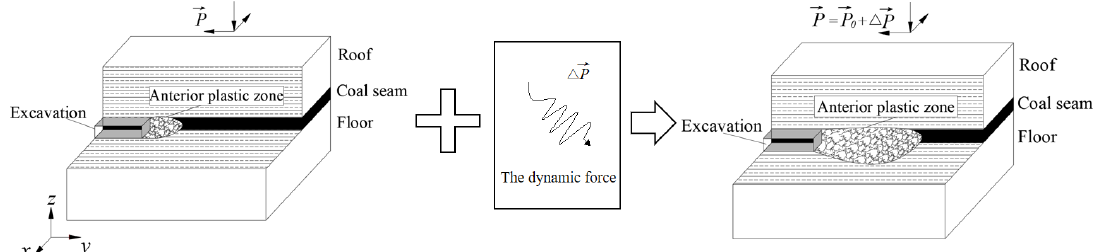
Figure 5. Schematic of the expansionary evolution of plastic zone ahead of excavation face.